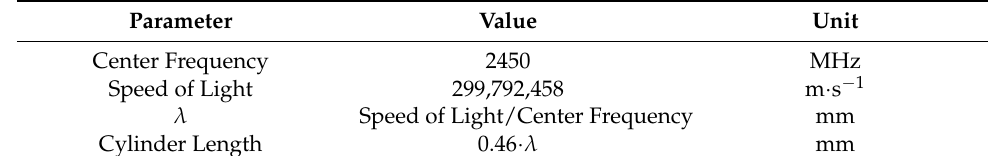
Table 1. Geometric properties of dipole antenna model.